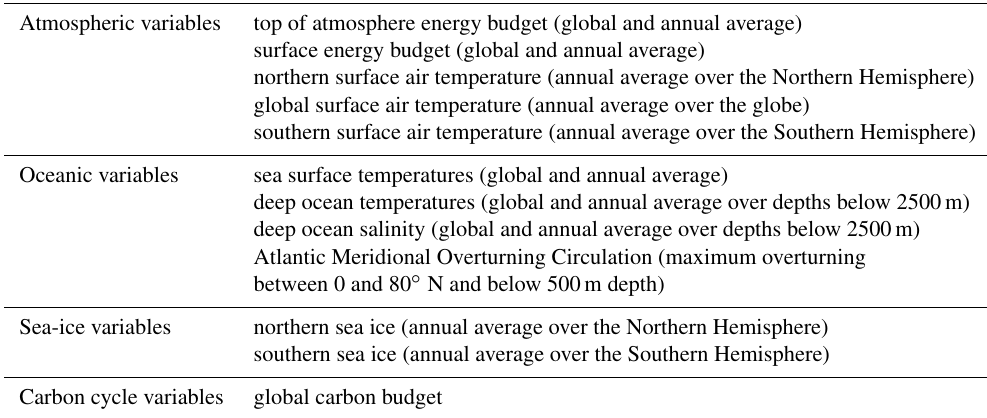
Table 3. Variables to be saved for the documentation of the spin-up phase of the models. Atmospheric